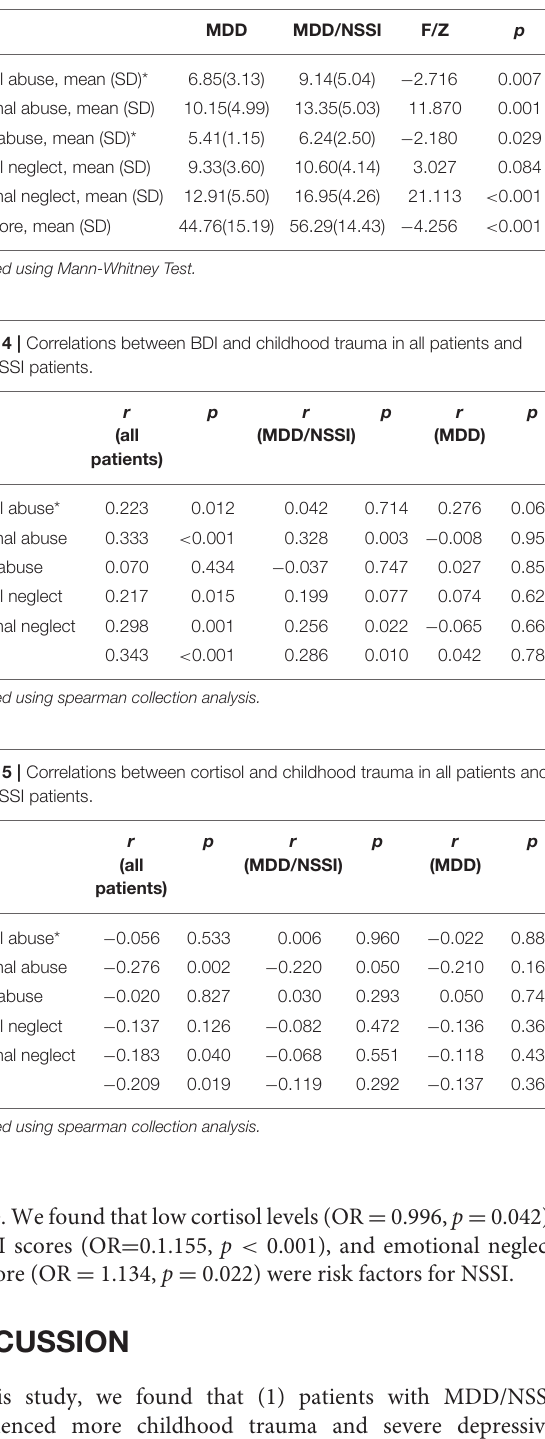
TABLE 3 | Experiences of childhood trauma between MDD patients with and without NSSI.